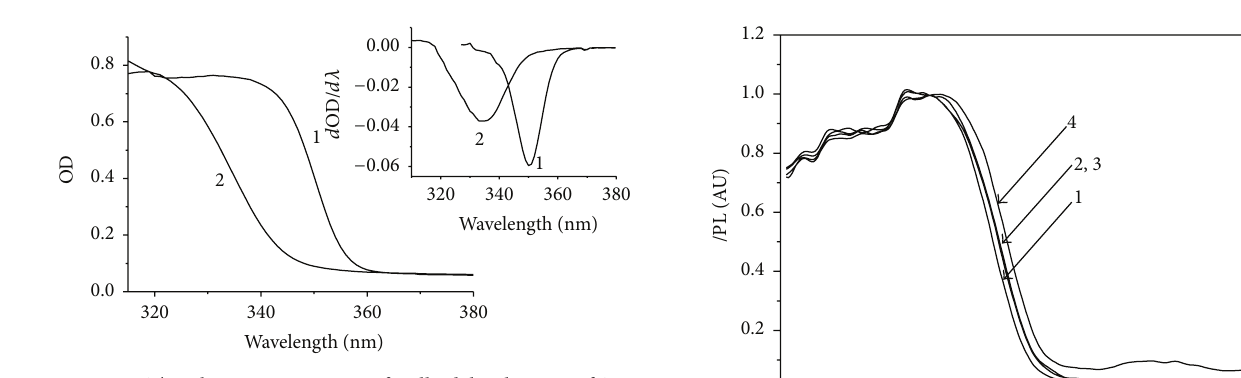
Figure 6: The absorption spectra of colloidal solutions of ZnO nanoparticles in ethanol with zinc oxide concentration during the synthesis: [ZnO] = 2 × 10 −2 mol/L (1); [ZnO] = 2 × 10 −3 mol/L (2). The inset shows the first derivative of the absorption curves 1 and 2, respectively. The optical thickness of the cuvette 𝑙 = 1.0 cm; the concentration during the spectra recording [ZnO] = 2 × 10 −3 mol/L.